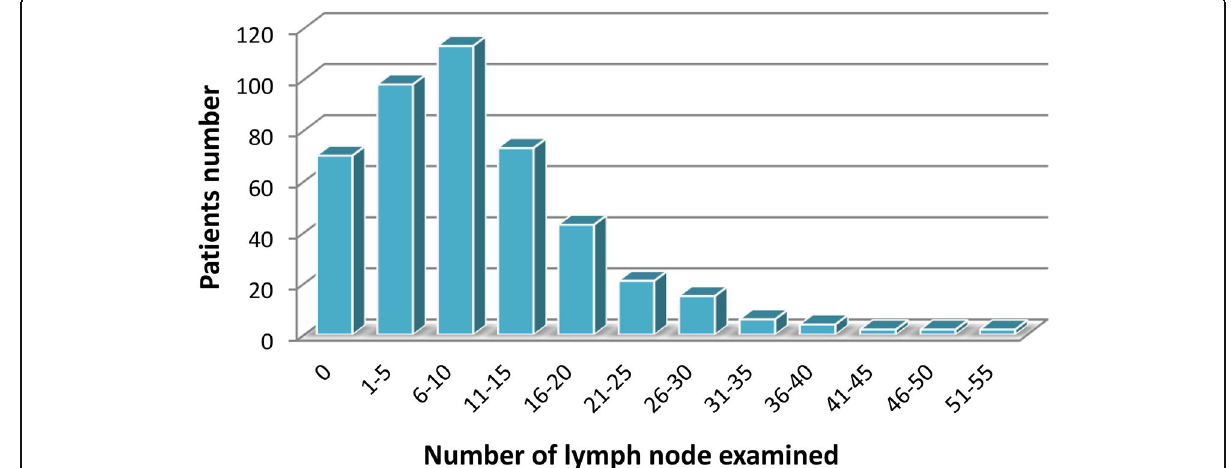
Fig. 1 Relative distribution of total lymph node evaluation in 449 patients with resected gastric